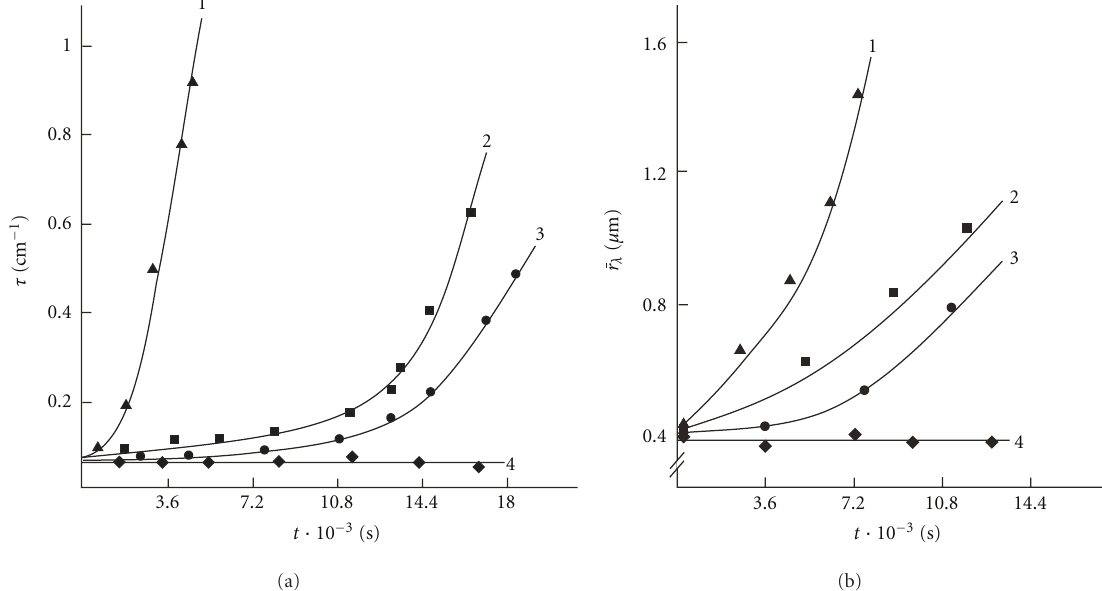
Figure 2: Kinetics of the turbidity τ at λ = 540 nm (a) and the particle size r λ (b) for the CTA-nitromethane system with a polymer concentration of 2 wt% at temperatures of –5 ◦ (1), 8 ◦ (2), 11 ◦ (3), and 20 ◦ C